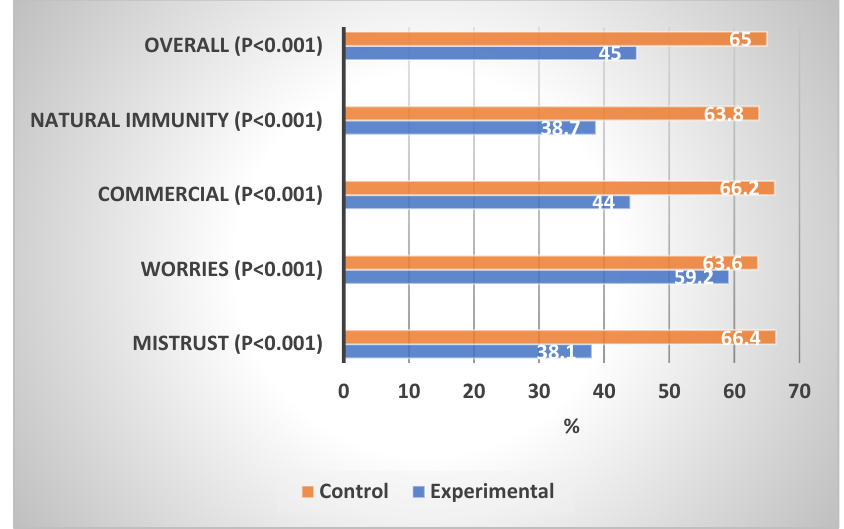
Figure 3. Percentage mean scores of COVID-19 concerns of the experimental and control groups.